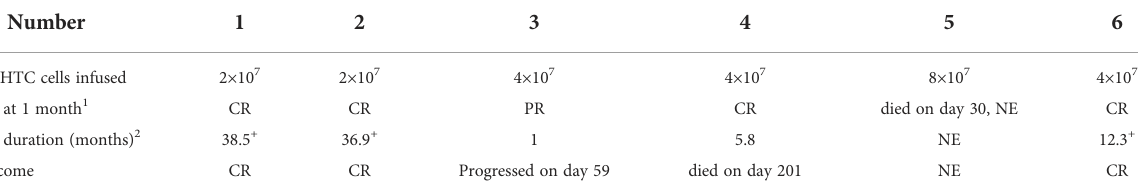
TABLE 3 Clinical ef fi cacy after NAHTC